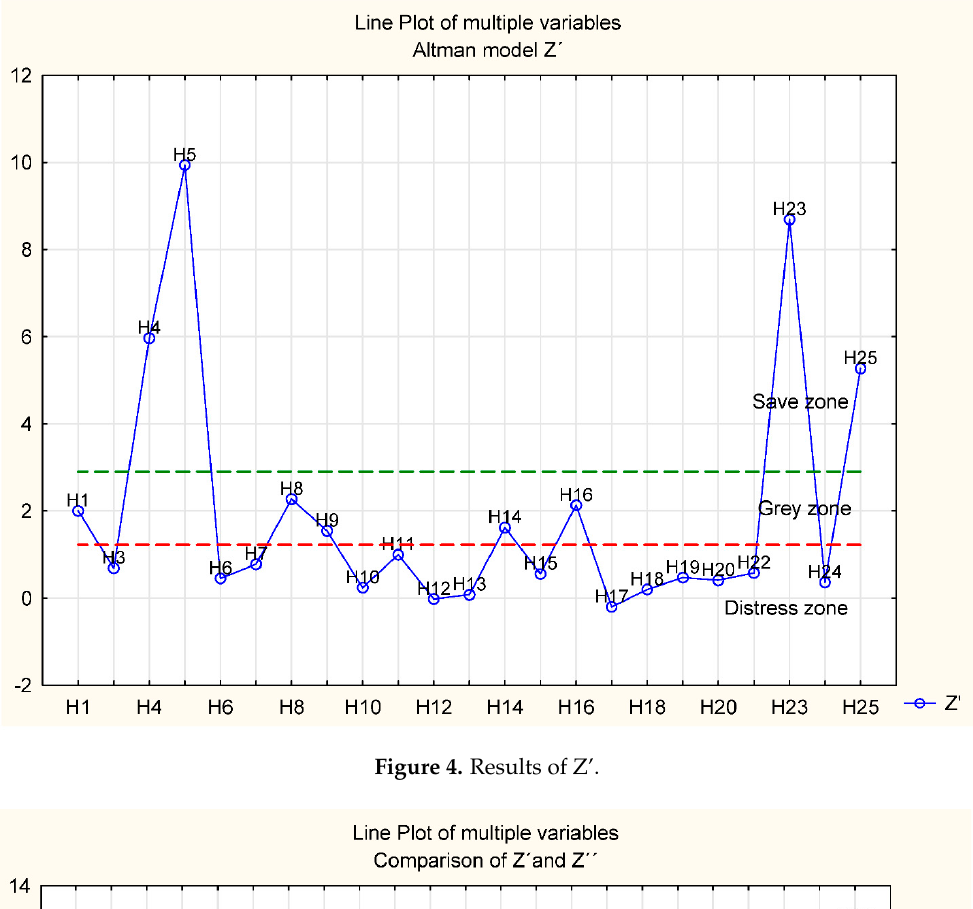
Figure 4. Results of Z’.